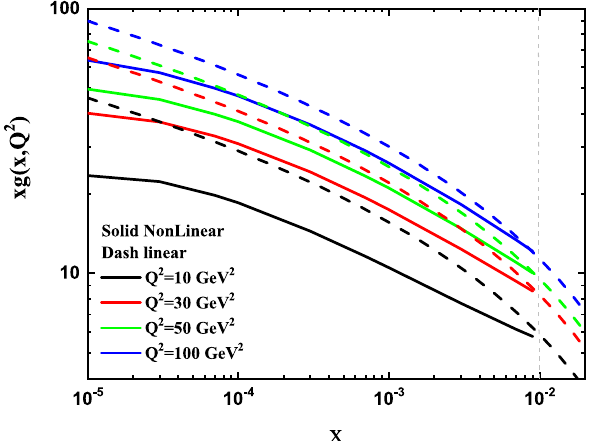
Fig. 1 The linear and nonlinear gluon distribution function at R = 2 GeV − 1 for Q 2 = 10 , 30 , 50 and 100 GeV 2 with respect to the parametrization model [11] and GLR-MQ equation [50,51], respec- tively